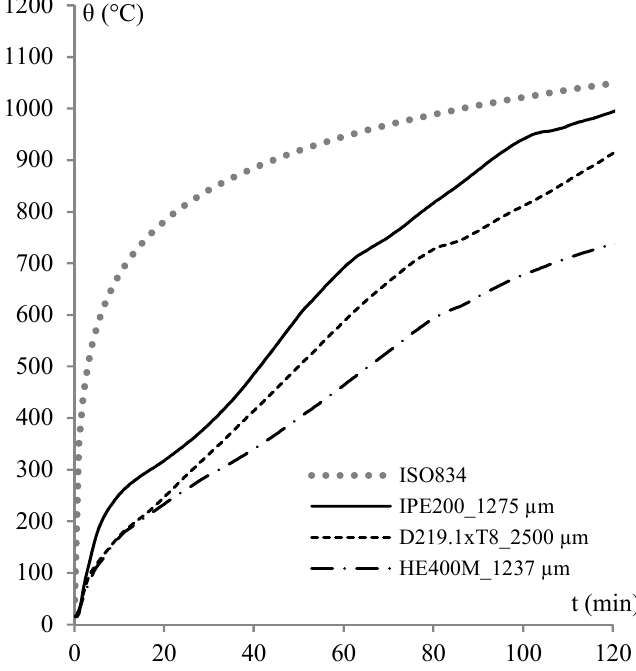
Figure 6. Specimens’ temperatures measured during the fire test.